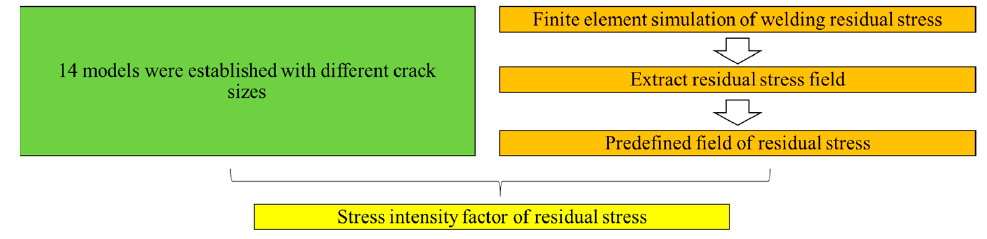
Figure 10. Flow chart for calculating the stress intensity factor of residual stress.